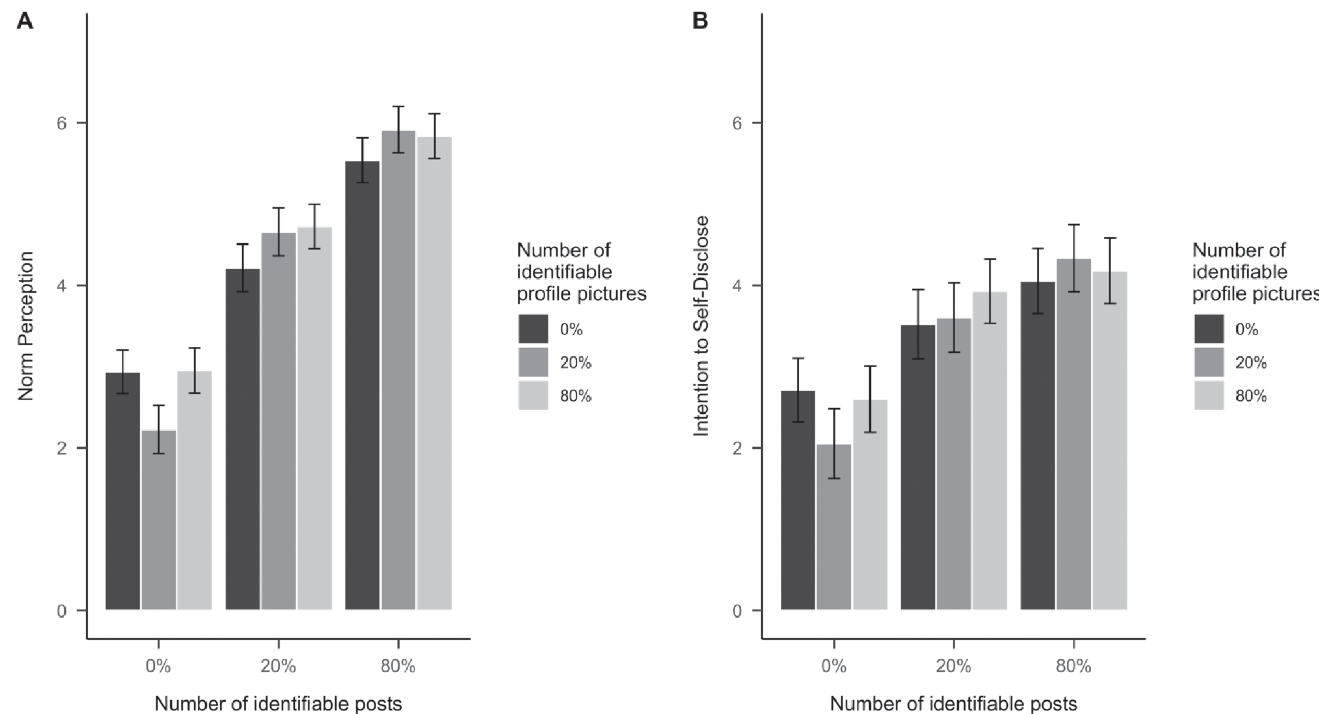
Fig 2. The effect of number of identifiable profile pictures and number of identifiable posts on norm perceptions (A) and intentions to self-disclose (B) in Study 1. Bars represent estimated marginal means. The error bars represent 95% confidence intervals.